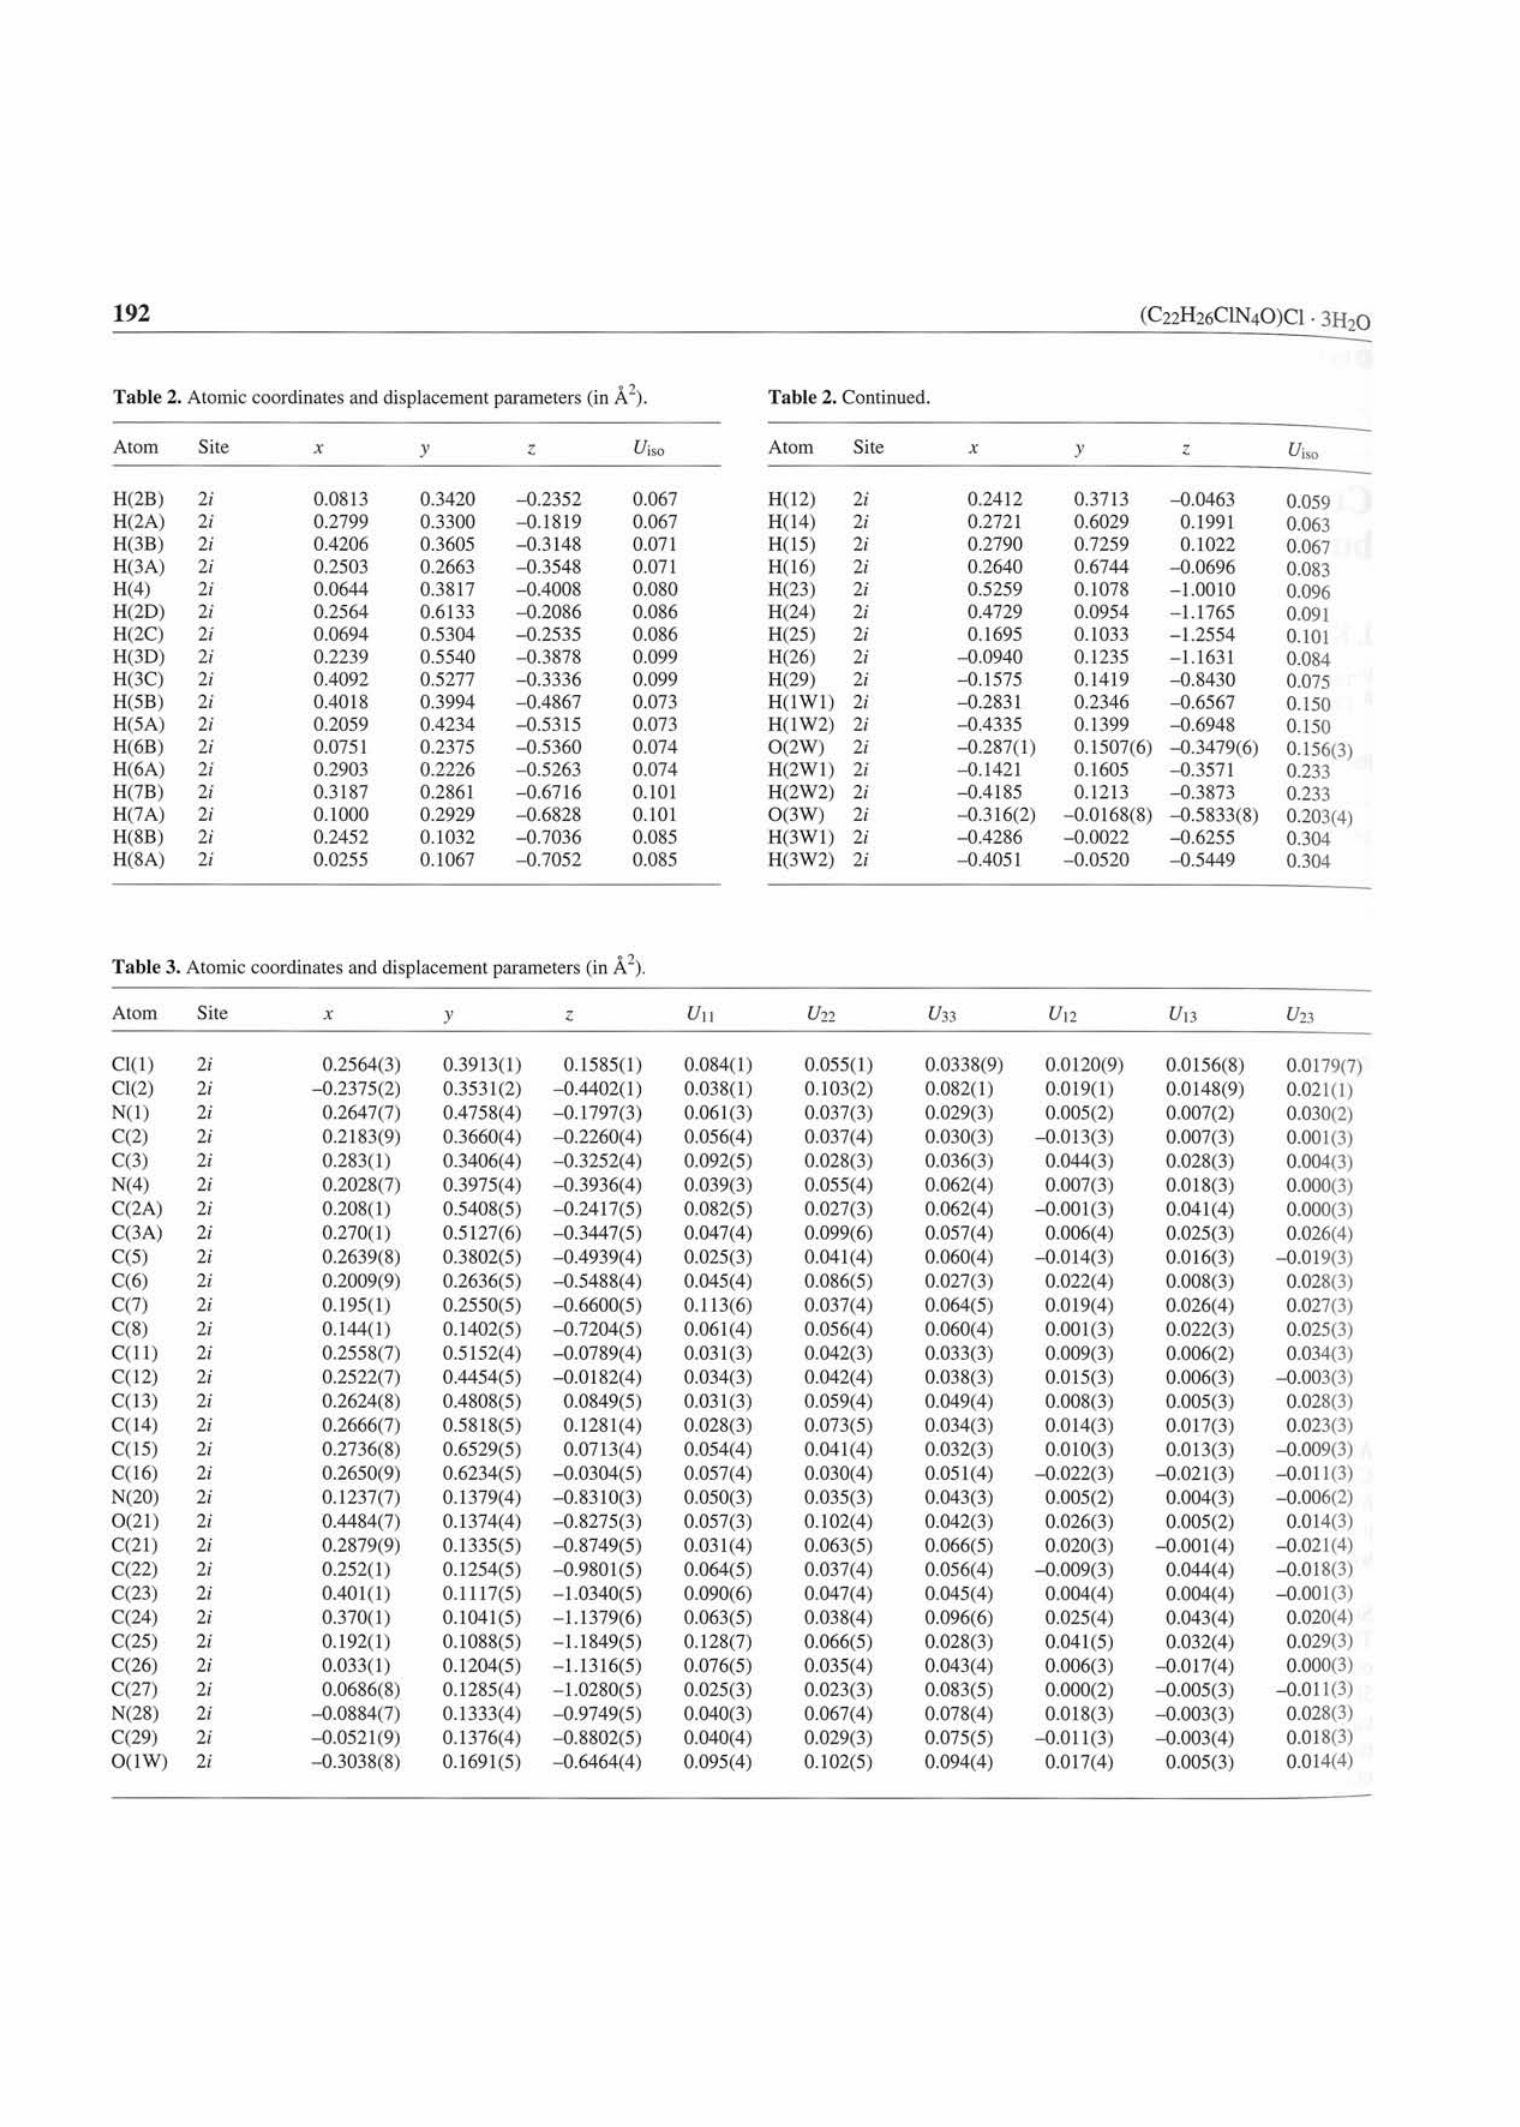
Table 2. Atomic coordinates and displacement parameters (in À 2 ). Table 2. Continued.